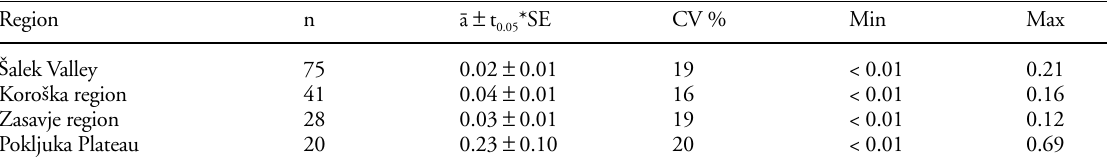
Table 3. Levels of Hg (mg kg –1 wet weight) in kidneys of roe deer shot in some Slovenian regions in 1997. The arithmetic means ( ā ) with the 95% confidence intervals, coefficient of variation (CV %) and range (Min, Max) are given. Region